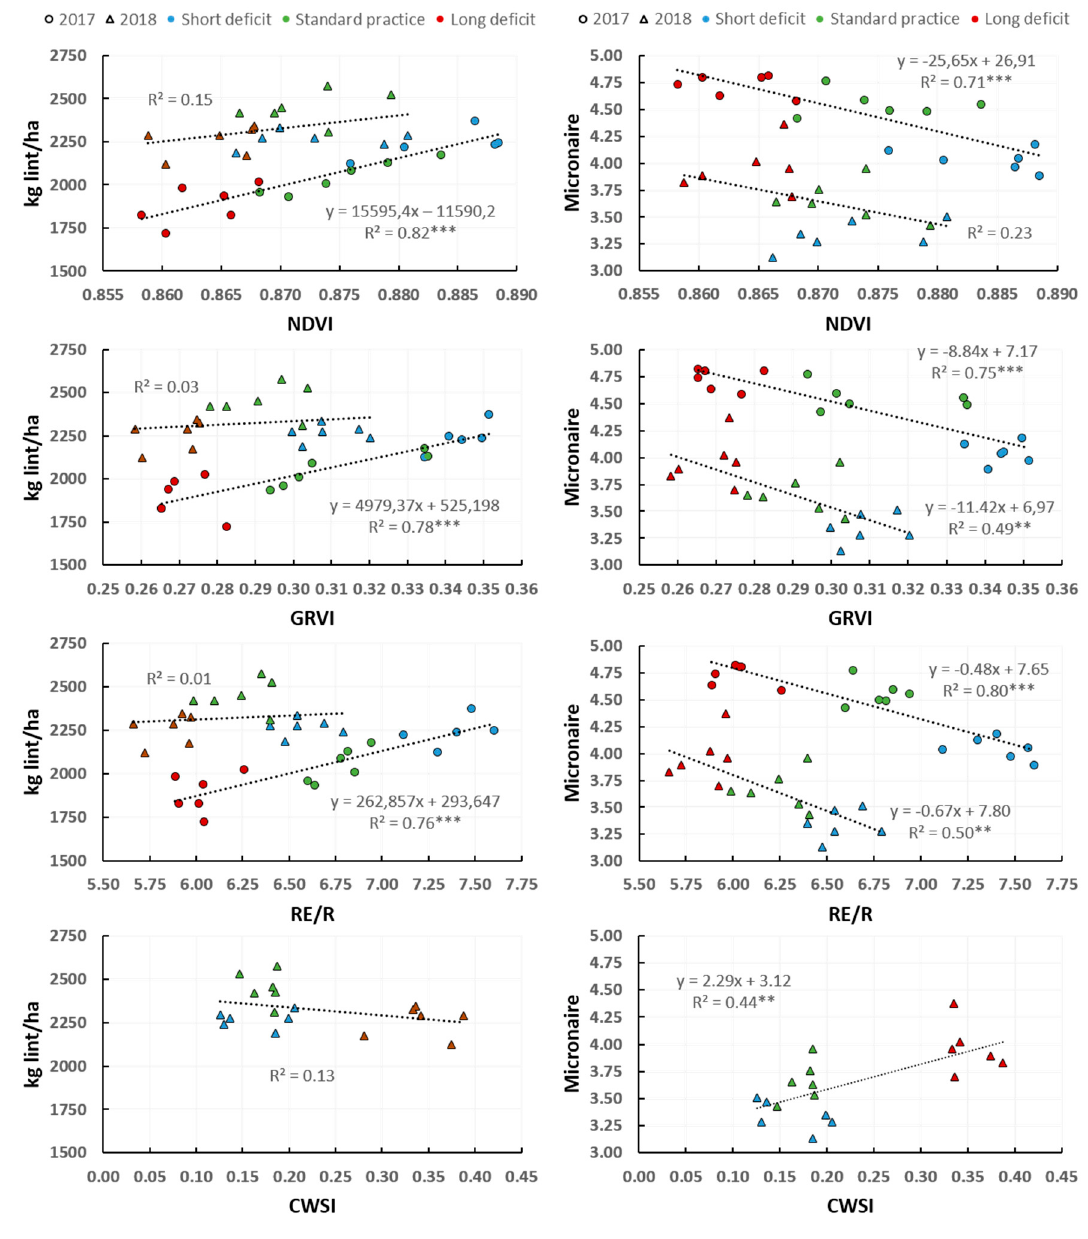
Figure 6. Relationships between lint yield and fibre micronaire with the subplot mean NDVI, GRVI, RE/R and CWSI for all the measurement dates within each growing season. ** and *** indicate statistical significance at p < 0.01 and p < 0.001, respectively.